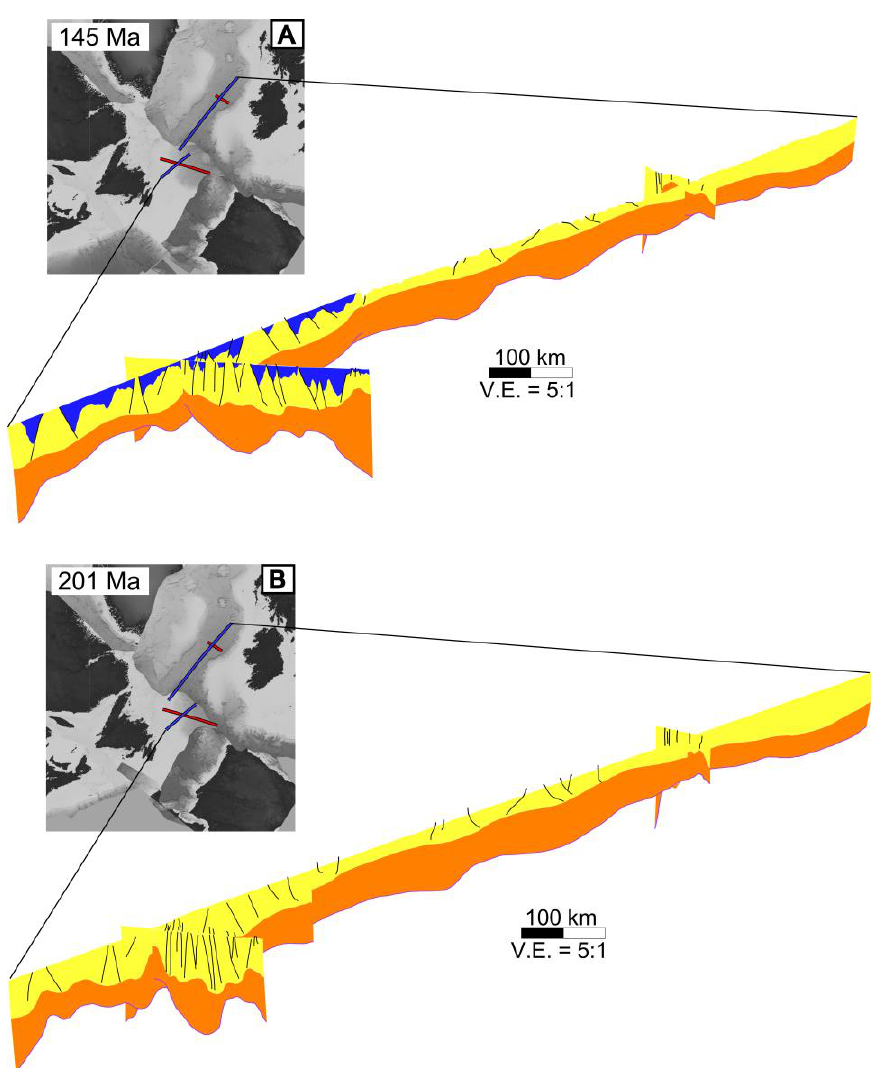
Figure 9. ( A ) Model in GPlates of the Newfoundland-Ireland conjugate margins with modern bathymetry reconstructed to 145 Ma with 3D model of seismic lines NL1 and NL2 (left) in the Orphan Basin and of seismic lines IR1 and IR2 (right) in the Rockall Basin with the Jurassic sedimentary sequence decompacted, restored and unfolded for the Newfoundland margin. ( B ) Model in GPlates of the Newfoundland-Ireland conjugate margins with modern bathymetry reconstructed to 201 Ma with 3D model of seismic lines NL1 and NL2 (left) in the Orphan Basin and of seismic lines IR1 and IR2 (right) in the Rockall Basin with the upper and lower crustal sequences rebounded, restored and unfolded. Black lines represent primary faults and red lines represent secondary faults. For meaning of layer colours, see legend in Figure 6.